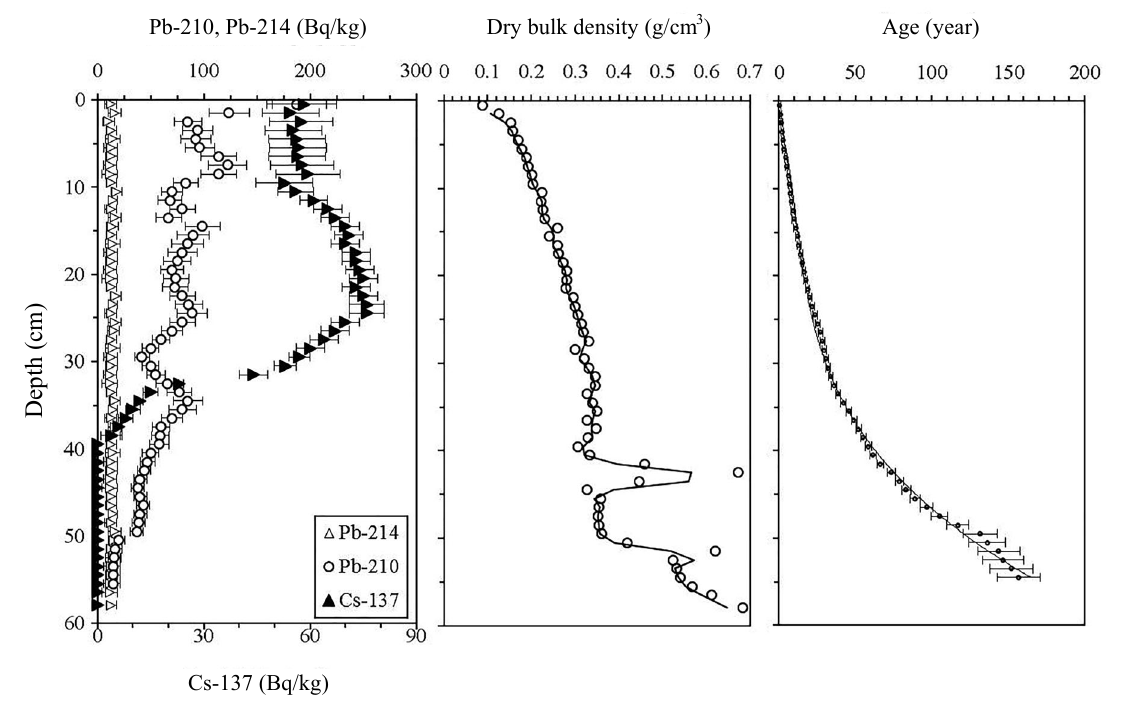
Fig. 3. The activity concentration of 210 Pb, 214 Pb and 137 Cs versus depth (1.0 cm thick slices) in the sediment core, the sediment dry bulk density versus depth (with a moving average trend line) and the sediment age–depth model based on the constant rate of 210 Pb supply (CRS) approach (the line represents a polynomial function with R 2 =